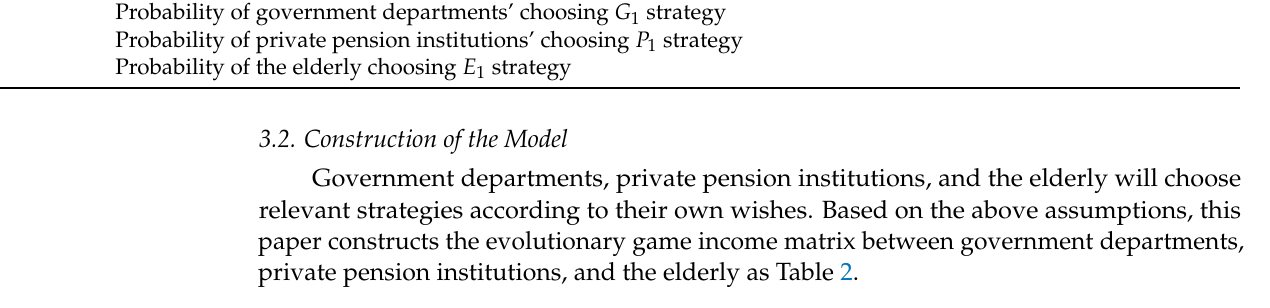
Table 2. The payoff matrix. (The combined income